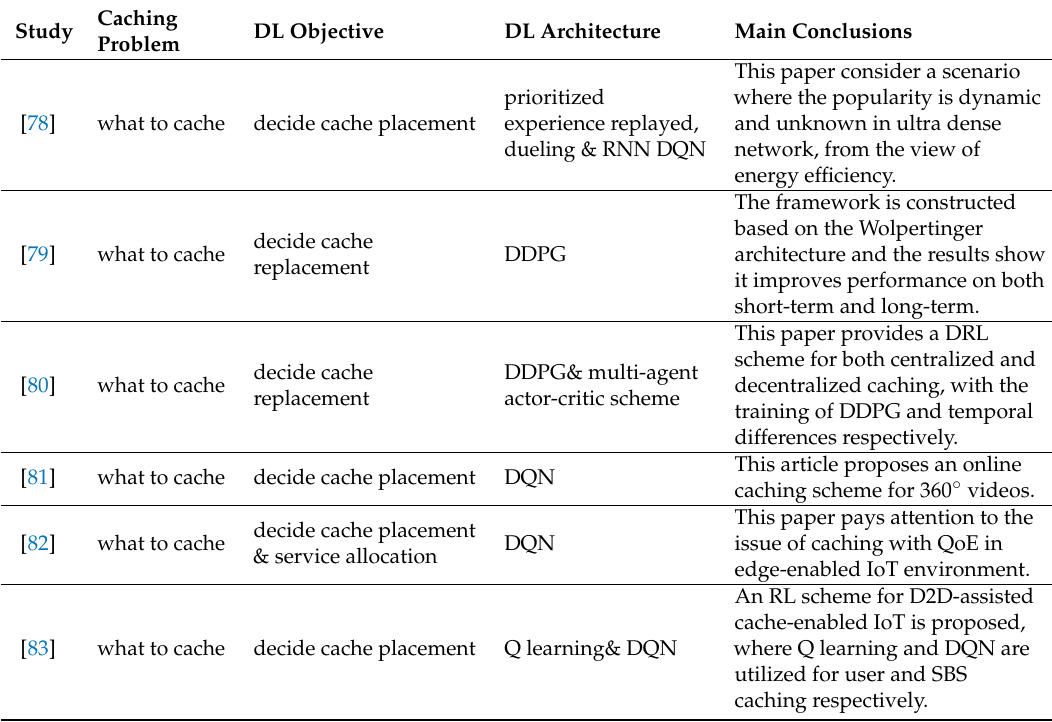
Table 6. Summary of deep reinforcement learning (DRL) for data